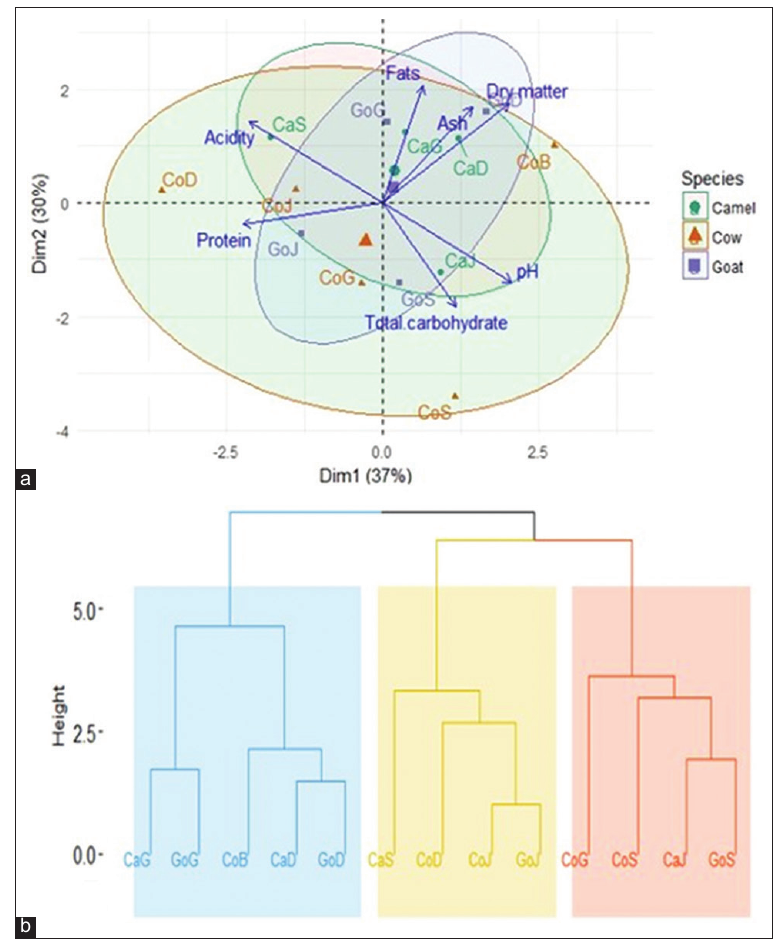
Figure-3: Principal component analysis distribution of fermented milk samples and ellipse of inertia different species on the factorial plane according to physicochemical parameters (a), ascending hierarchical clusters according to physicochemical parameters of fermented milk from different species